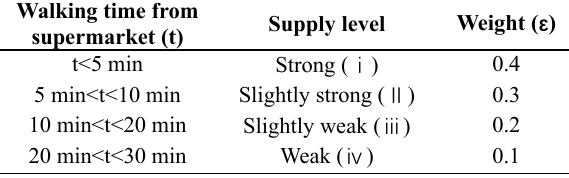
Table 3. Classification of supermarket supply level